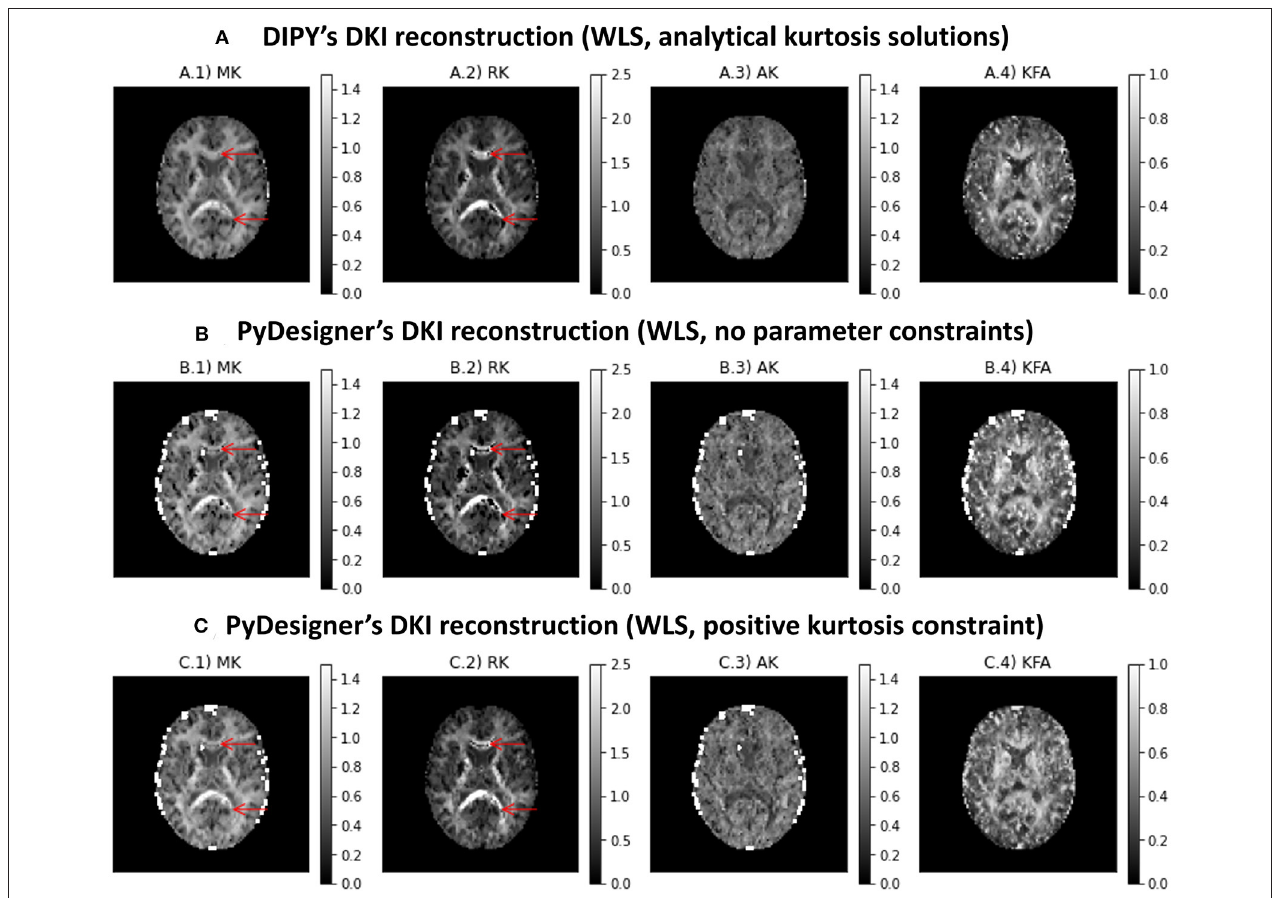
FIGURE 6 | Kurtosis maps obtained from a subset of the in vivo human brain dataset using three different estimators: (A) DIPY DKI NLS estimator; (B) PyDesigner with no parameter constraints; (C) PyDesigner constraining the apparent directional kurtosis values to positive values. Left to right panels show the maps of mean kurtosis (A.1,B.1,C.1,D.1), radial diffusivity (A.2,B.2,C.2,D.2), axial diffusivity (A.3,B.3,C.3,D.3), and Fractional Anisotropy